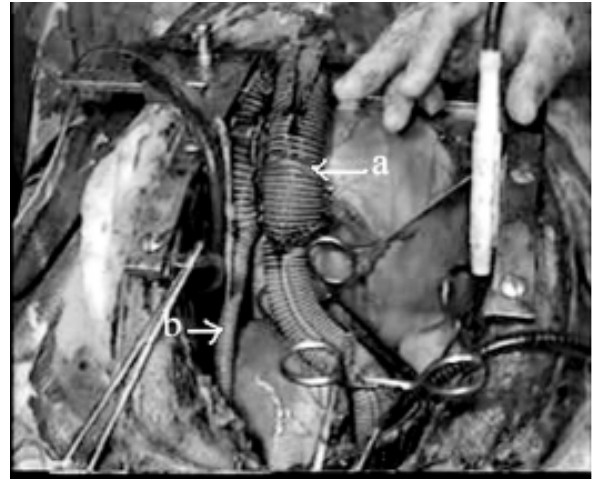
Fig. 3 - Ventrículo pulmonar criado (a). A conexão arterial pulmonar do ventrículo pulmonar criada através de enxerto Dacron de 8 mm